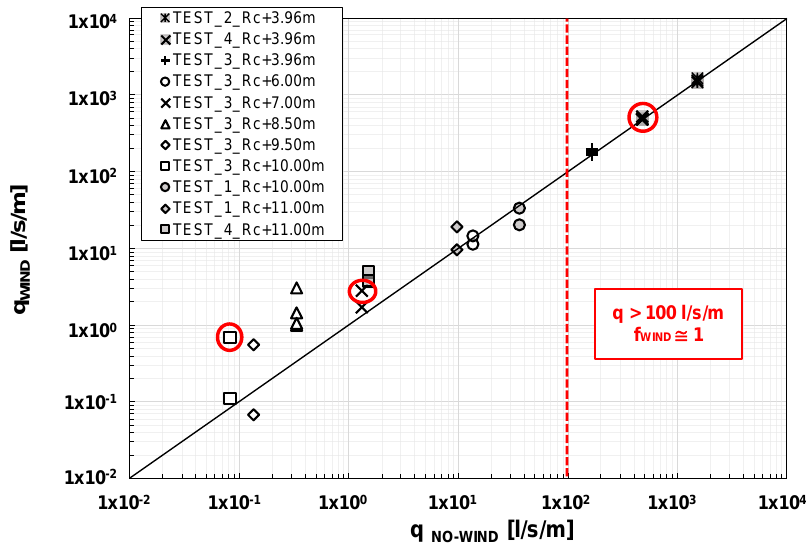
Figure 13. Numerical results of wind influence with different wave conditions and different Rc.